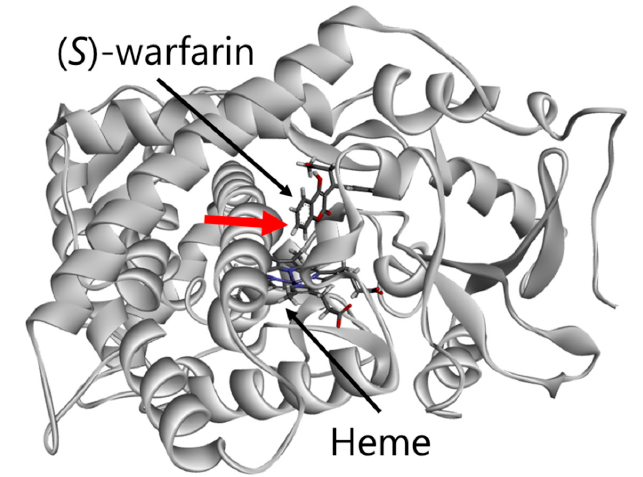
Figure 4. Diagram of the overall structure of CYP2C9. Red arrow represents metabolic site. The distance between central iron and metabolic site was 8.70 Å.